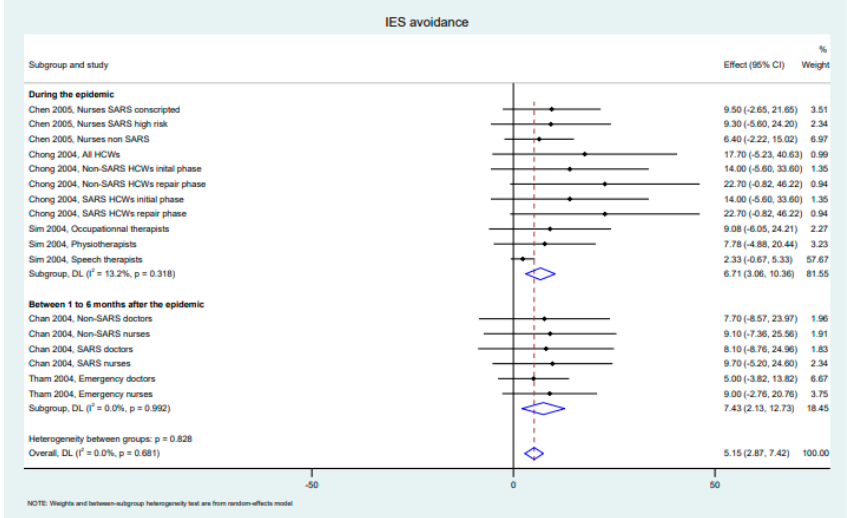
Figure A3. Meta-analysis on IES score (total, intrusive and avoidance) following the SARS-CoV-1 epidemic of 2003.